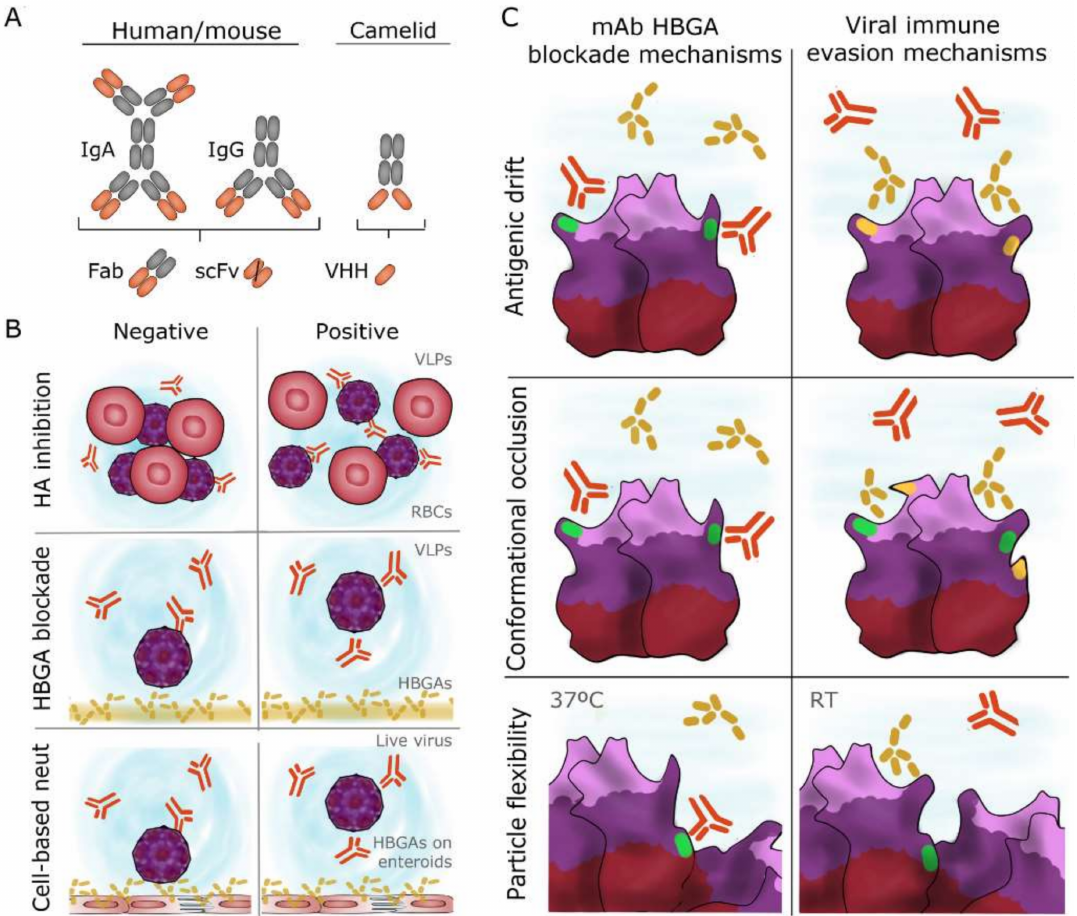
Figure 3. Monoclonal antibody types and their functional characterization. ( A ) Types of monoclonal antibodies used to map norovirus epitopes are shown. Intact immunoglobulins derived from